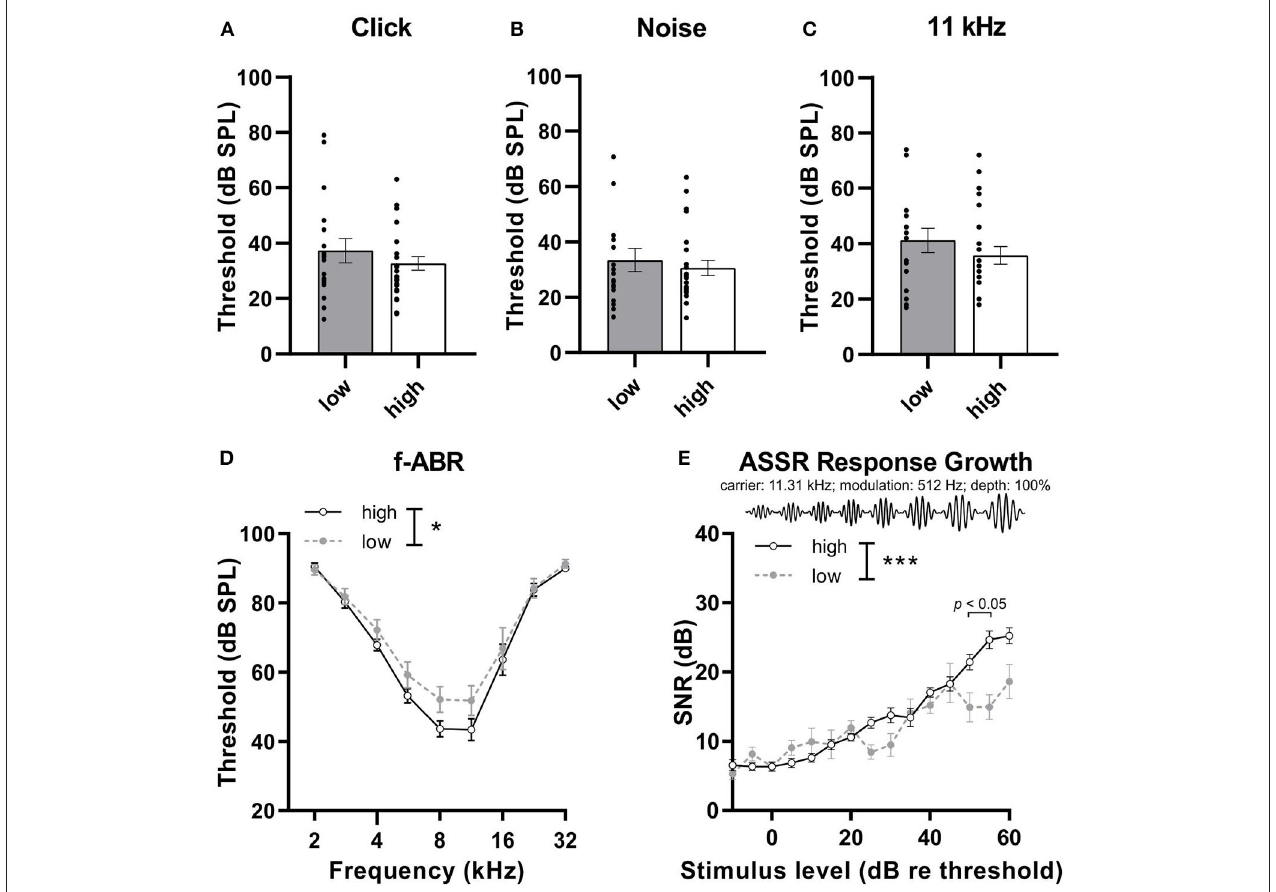
FIGURE 2 | The hearing phenotype of low and high compensators before treatment. (A) Low and high compensators showed similar thresholds in response to click and (B) noise stimuli. (C) High and low compensators showed similar thresholds in response to 11kHz pure-tone stimuli. (D) However, with pure-tone, frequency-specific auditory stimuli (2-32kHz), low compensators showed elevated thresholds compared to high compensators. (E) The temporal auditory resolution was significantly decreased in low compensators in comparison to high compensators. Re threshold, relative to threshold. Mean ± SEM. * p < 0.05, *** p < 0.001, 2-way ANOVA.